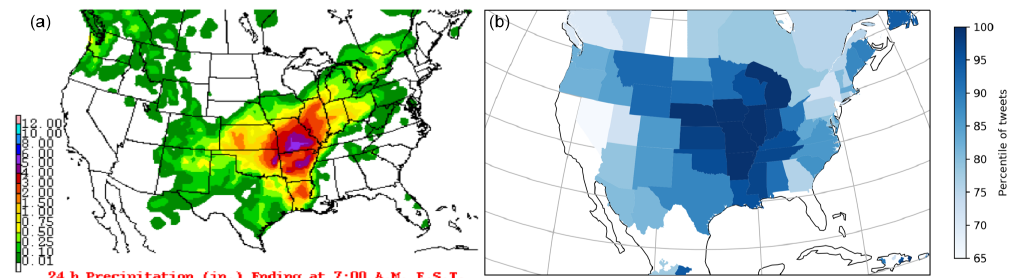
Figure 4. (a) The 24h precipitation (inches; ranging from 0 to 305mm) for USA on 30 April 2017 (http://www.wpc.ncep.noaa.gov, last access: 17 December 2020). (b) Map of North America showing the percentile of tweet activity for each GADM level 1 administrative area on 30 April